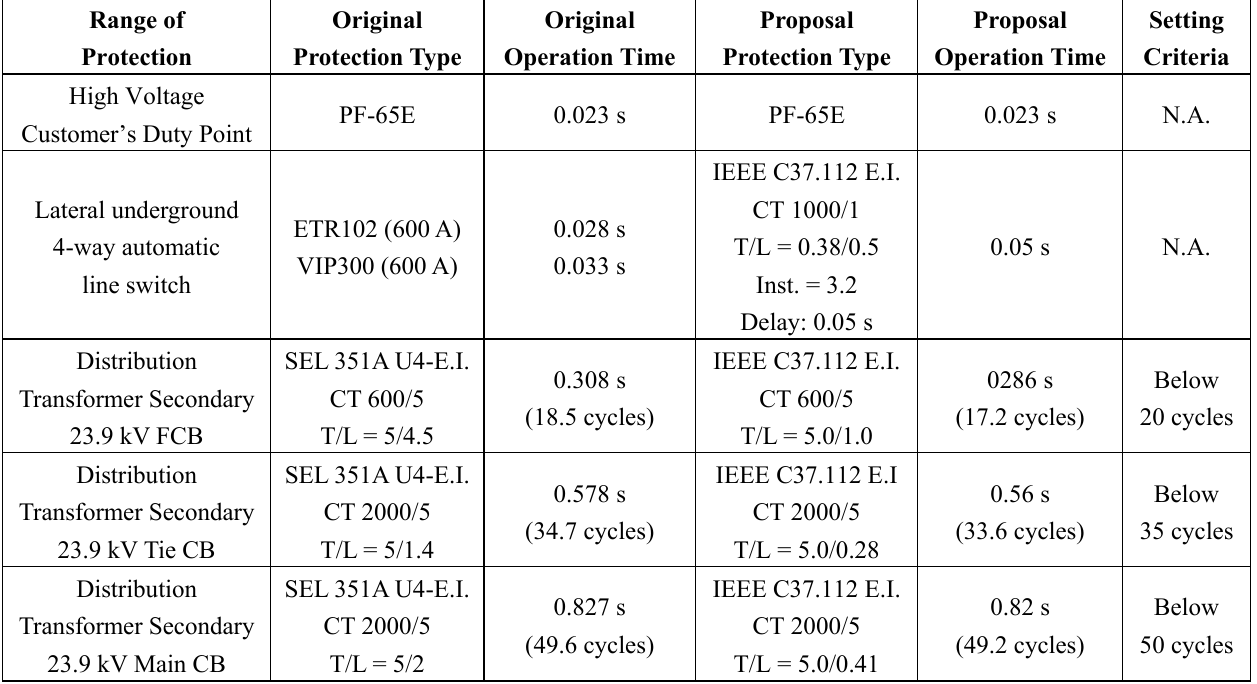
Table 4. Original and proposed CO relays of Minsheng